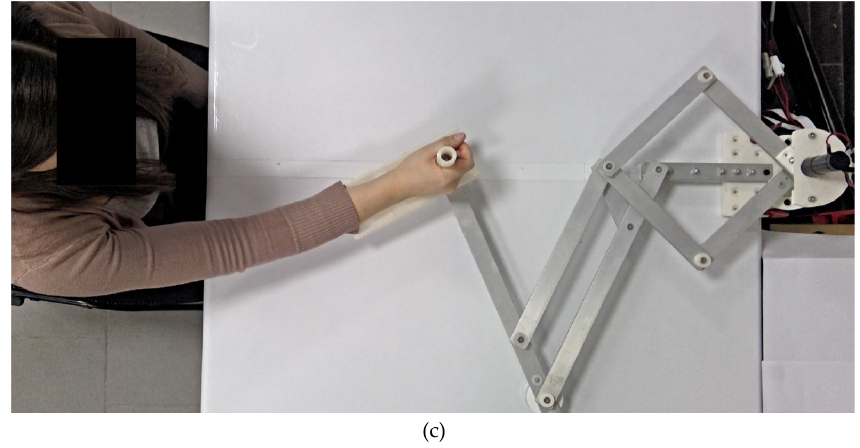
Figure 8. Prototype of the proposed mechanism: (a) Lab prototype; (b) Mechanism prototype in retracted position while it is easily lifted by a person; and (c) User-mechanism interaction.